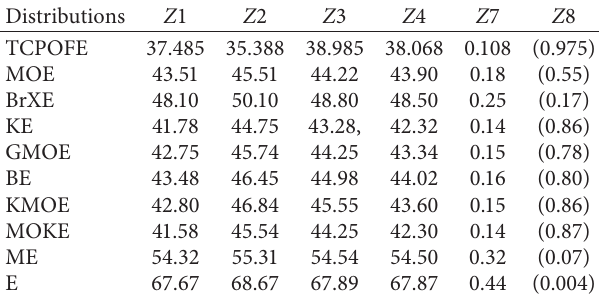
Table 3: Estimates for dataset II. Table 5: Some IC for dataset